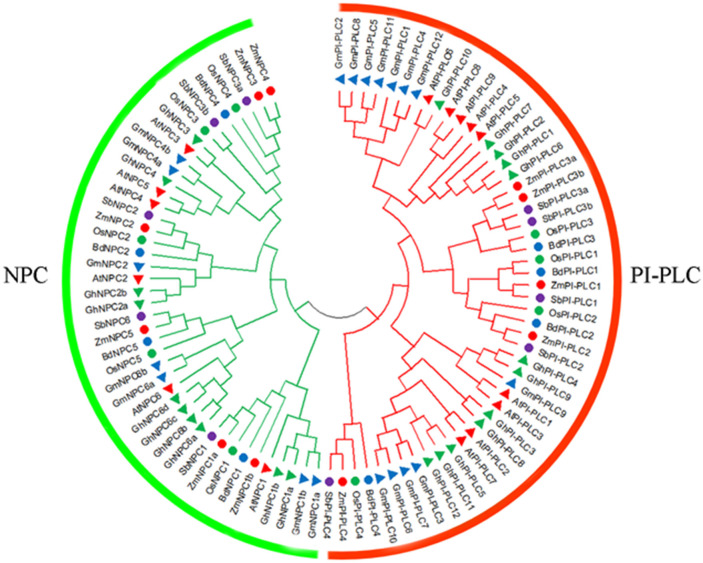
Phylogenetic analysis of the PLC family. The phylogenetic tree was made by MEGA 7.1 software using the neighbor-joining (NJ) method with bootstrapping analysis. The analysis involved 94 amino acid sequences from various plants, including Arabidopsis thaliana (At), Glycine max (Gm), Oryza sativa (Os), Sorghum bicolor (Sb), Gossypium hirsutum (Gh), Brachypodium distachyon (Bd).